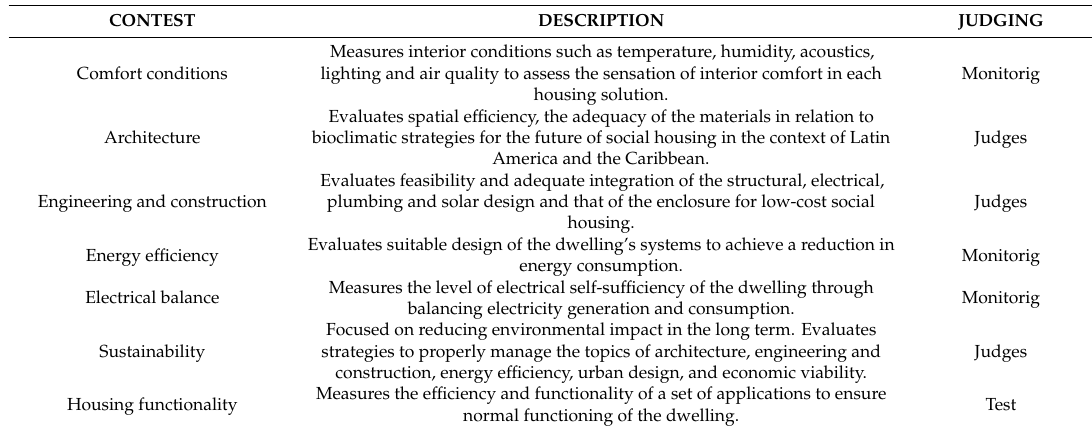
Table 2. Analysis of the 10 contests of the Competition: summary table generated from the SDLAC15 Competition Rules, but with our own